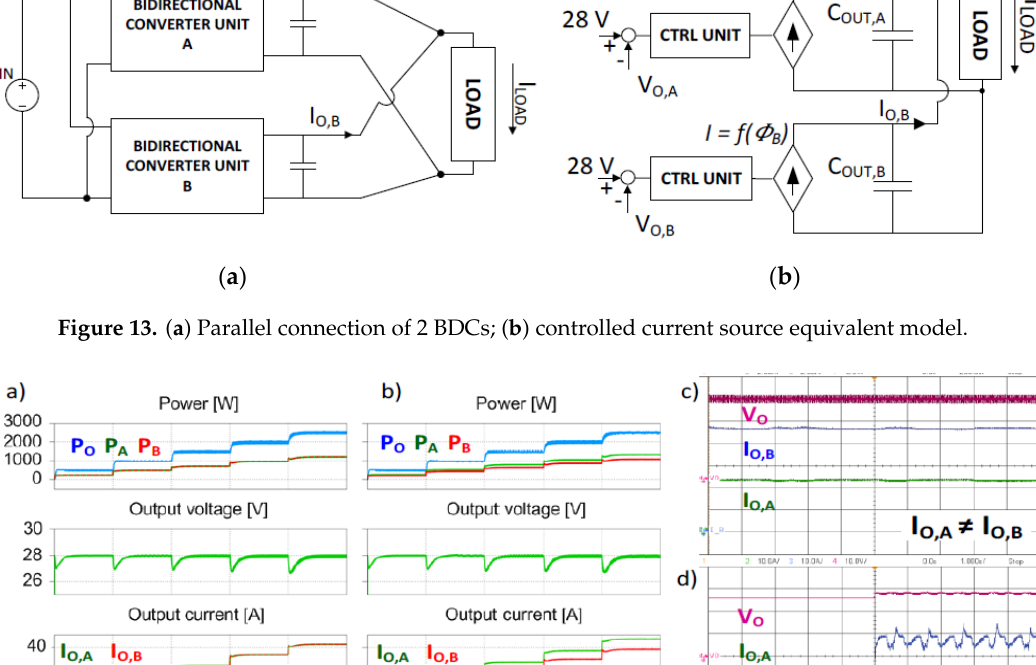
Figure 15. Structure of closed-loop system for parallel operation with current compensator.